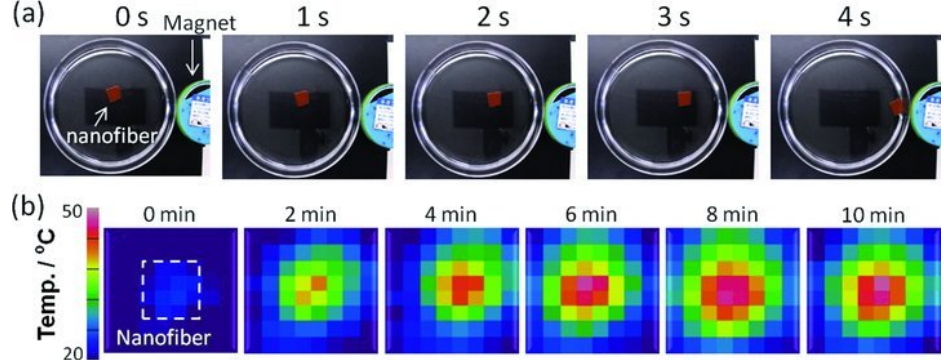
Figure 8. ( a ) Magnet ‐ responsive behaviour of DOX/MNPs ‐ nanofibres. ( b ) Time ‐ dependent infrared thermal images of the DOX/MNPs ‐ nanofibres in an AMF. Reprinted/adapted with permission from Ref. [67]. 2022, John Wiley and Sons.